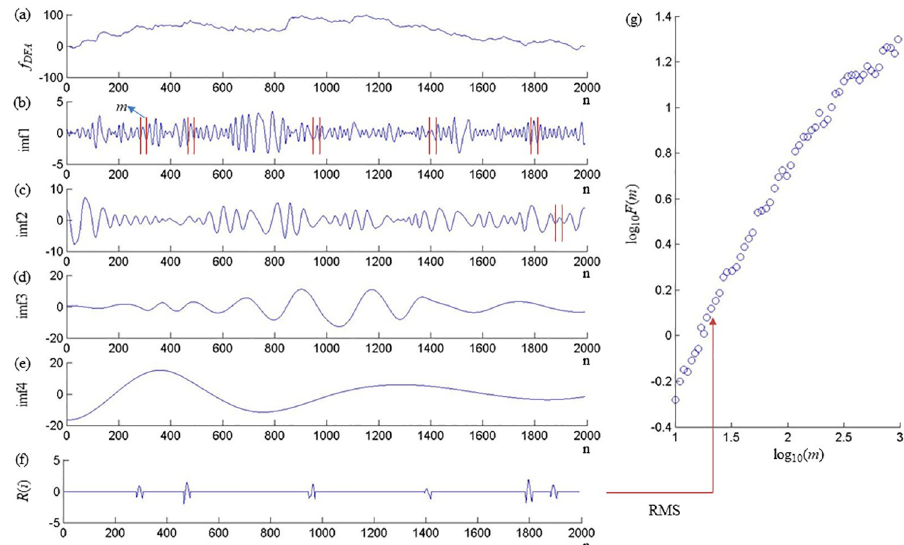
Fig 3. Processing of a representative signal using the